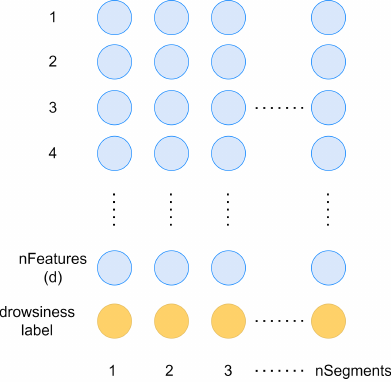
Figure 8. The structure of the generated EEG data